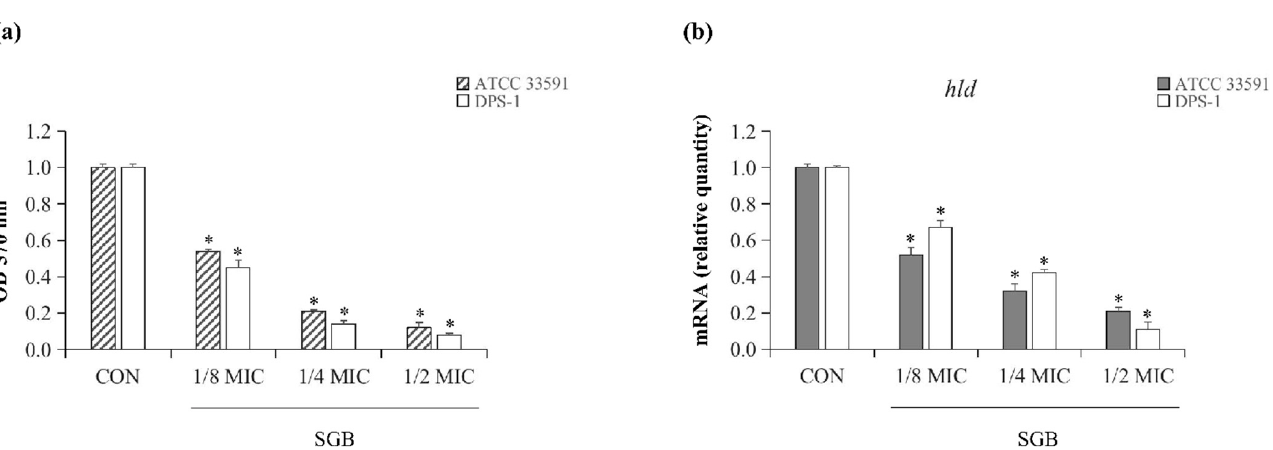
( c ) Figure 4. TEM images of MRSA (ATCC 33591) after treatment with SGB. ( a ) Untreated control MRSA. ( b ) MRSA treated with 1/2 MIC of SGB (6.3 μ g/mL). ( c ) MRSA treated with the MIC of SGB (12.5 μ g/mL). 2.6. Cytotoxicity and Hemolysis Activity of SGB The potential cytotoxicity and hemolysis activity of SGB was investigated to exclude the toxicity of SGB toward mammalian cells. The result showed that the IC 50 value against